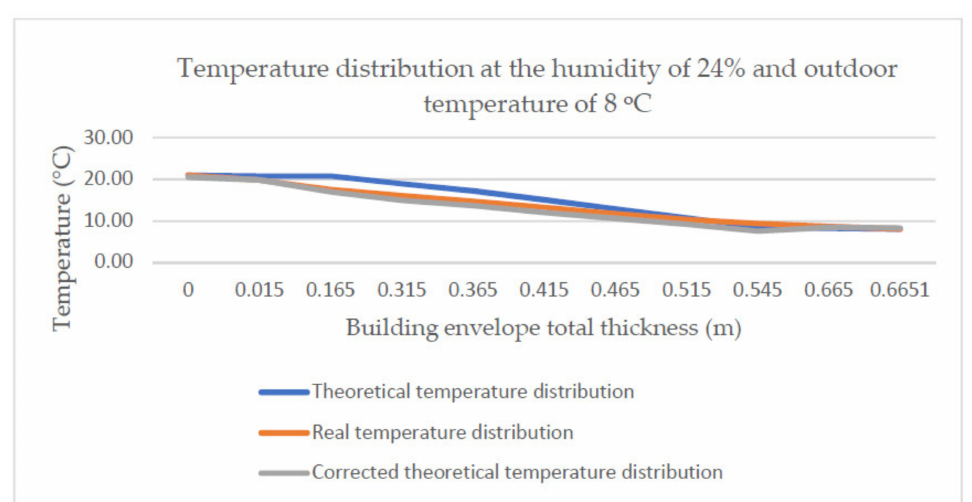
Figure 17. Temperature distribution at the humidity of 46% and outdoor temperature of 9 ◦ C together with the corrected distribution.